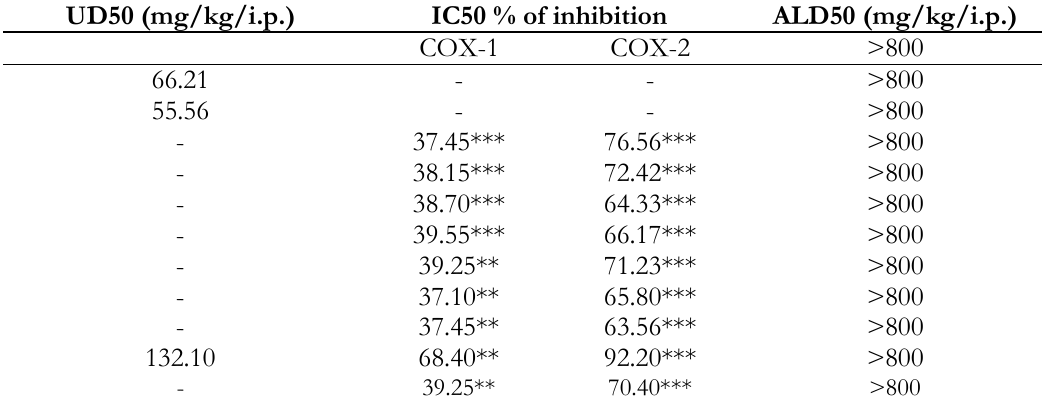
Table IIb. Antimicrobial data for the synthesized compounds 4 and 5(a-h). UD50